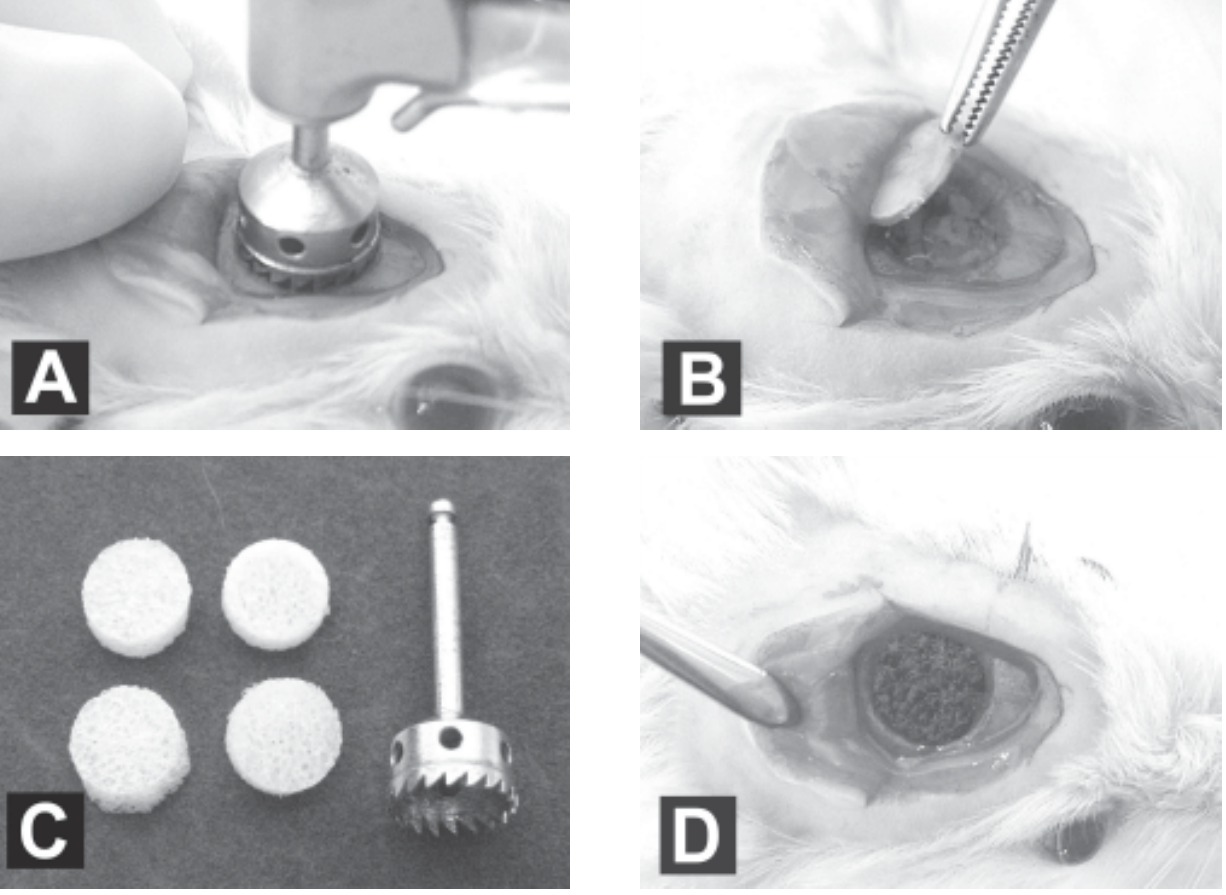
FIGURE 2.- Surgical procedures; A ) perforation of the parietal bone with trephine; B ) exposure of the dura mater at the bottom of the defect; C ) defect filled with a circular block of organic bovine bone; and E ) replacement and suture of soft